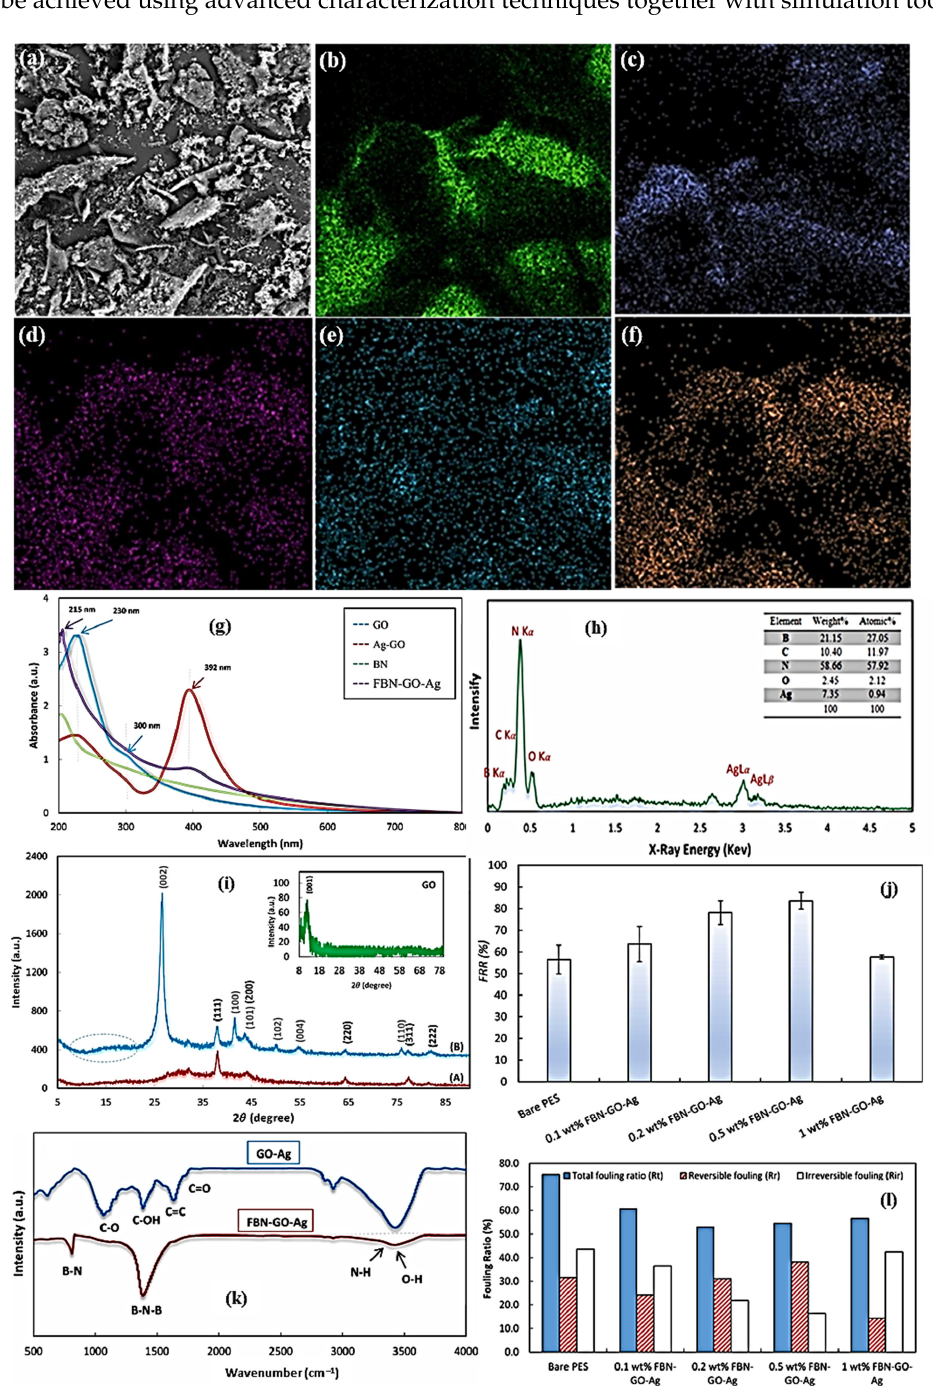
Figure 21. ( a ) SEM micrograph of BN/Ag/GO nanocomposite. ( b – f ) Elemental mapping of BN/Ag/GO nanohybrids for different elements of ( b ) C, ( c ) N, ( d ) B, ( e ) Ag, and ( f ) O; ( g ) UV–vis absorption pattern of GO, Ag-GO, BN, and BN/GO/Ag dispersions; ( h ) EDX pattern of the synthe- sized FBN-GO-Ag nanocomposite; ( i ) XRD profile of (A) GO/Ag nanohybrid and (B) BN/GO/Ag nanocomposite and XRD spectra of GO (inset). ( j ) The flux recovery ratio of FBN-GO-Ag blended PES membranes; ( k ) FTIR spectra of the synthe-sized FBN-GO-Ag and GO-Ag; ( l ) The fouling ratios of FBN-GO-Ag blended PES membranes. Reproduced with the permission from